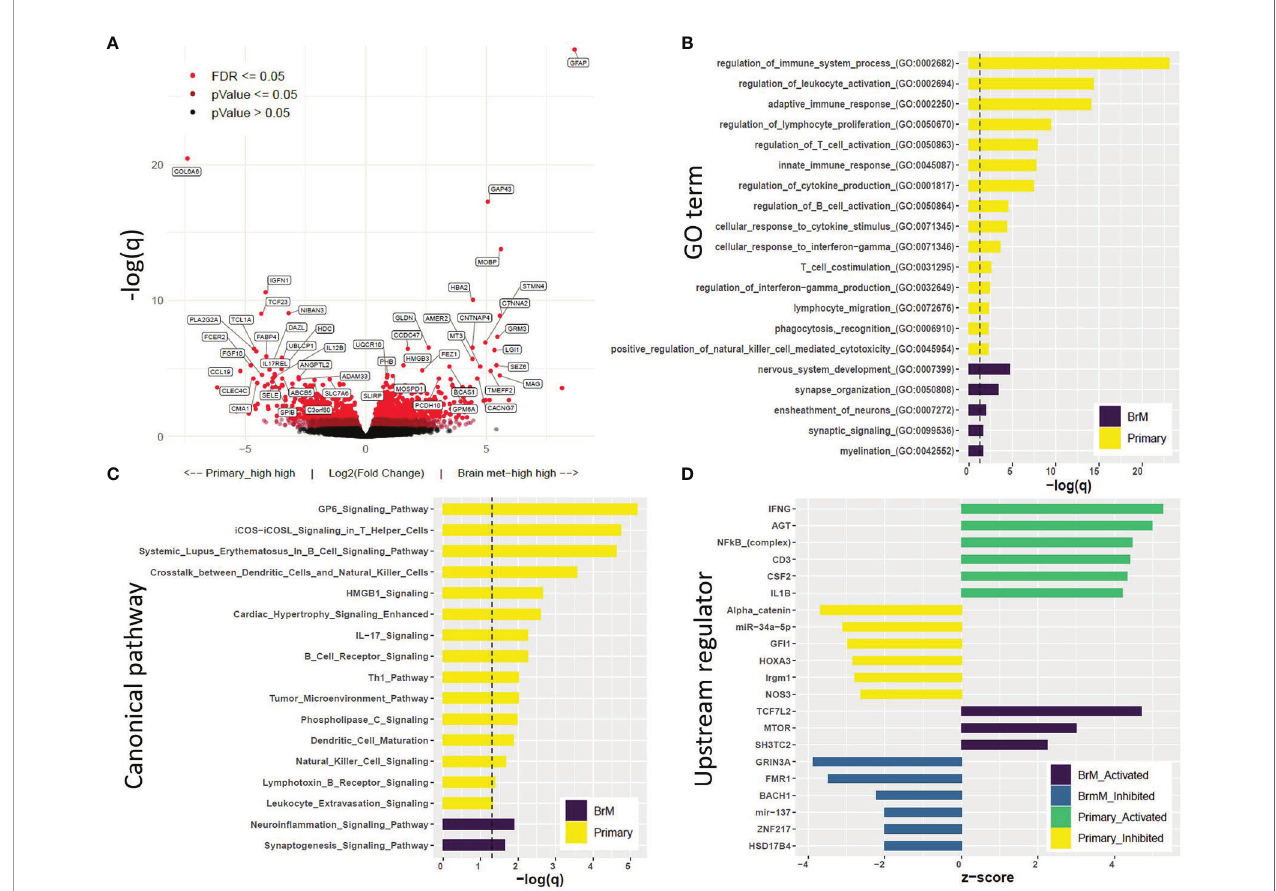
FIGURE 5 | Differential gene expression analysis and Gene Set Enrichment Analysis further support the immune cell de fi cit in BrM relative to primary triple-negative breast cancer (TNBC). (A) Volcano plot displaying differentially expressed genes (DEGs) in primary TNBC relative to BrM, with the legend showing color-coded levels of signi fi cance. (B) Top Gene Ontology terms associated with DEGs. DEGs with LFC > |1| and q < 0.1 (equating to 468 genes for primary_vs_BrM and 463 genes for BrM_vs_primary) were subjected to PANTHER overrepresentation test (dotted line represents q = 0.1). (C) Canonical pathway analysis (Ingenuity Pathway Analysis, IPA) of DEGs. The pathways displayed were signi fi cant at q < 0.05 (dotted line) and were associated with a signi fi cant z -score ( z >|2|) which indicates associative activity. (D) Upstream regulator analysis (IPA) displaying top regulators ( z >|2|, q < 0.1) identi fi ed to be associated with an active or inhibited state in primary versus BrM TNBC [see Supplementary Data S2, S3 for the full list of DEGs ( q < 0.1) and upstream regulators ( z >|2|, q